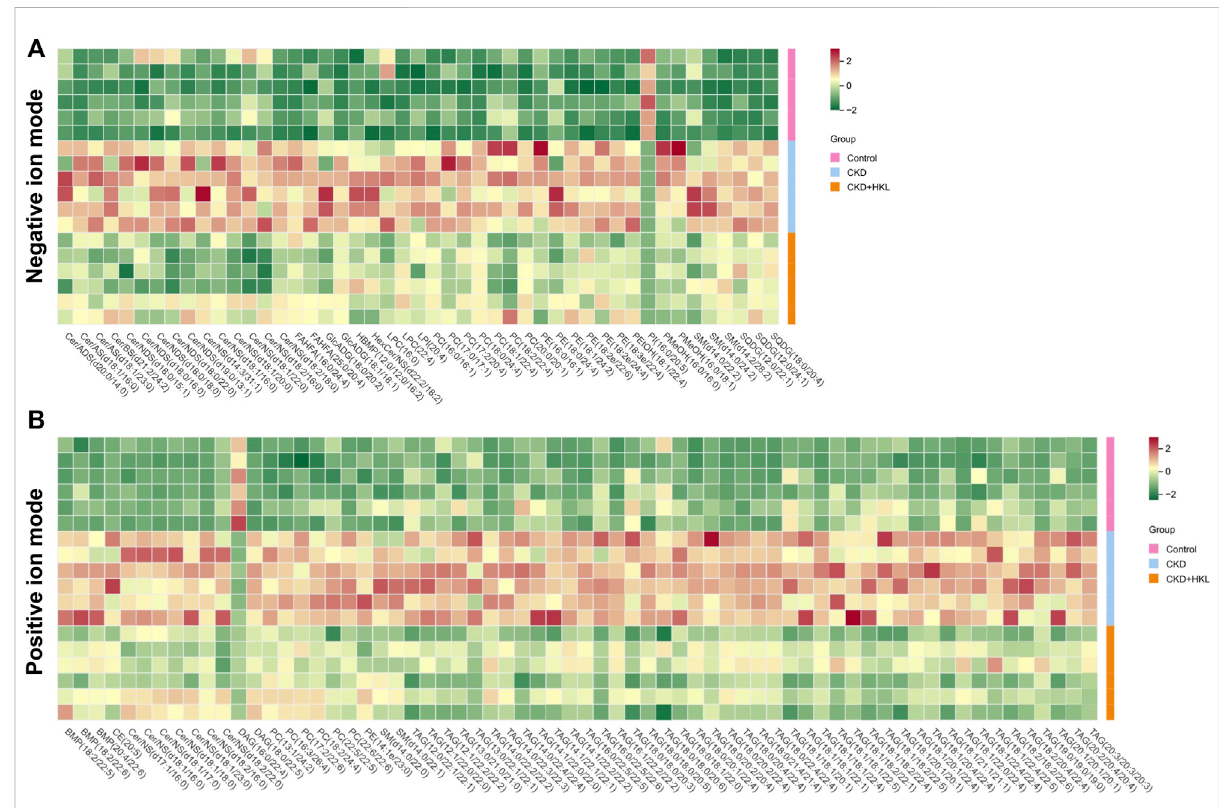
FIGURE 8 Heatmap analysis of the lipids reversed by HKL treatment in CKD rats. (A) Relative expression of 47 lipids in the control, CKD, and CKD + HKL group in negative ion mode. (B) Relative expression of 66 lipids in the control, CKD, and CKD + HKL group in positive ion